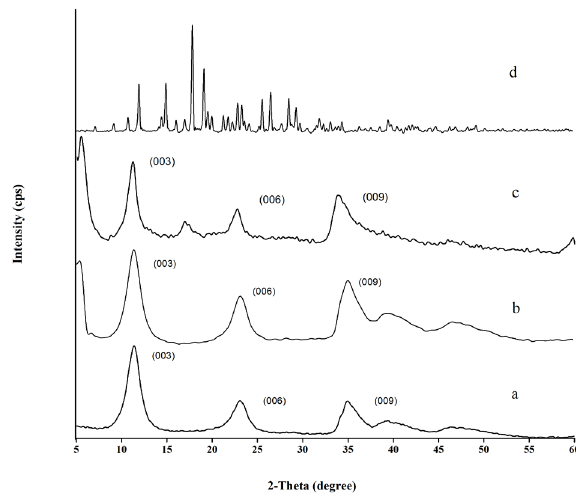
(a); Ni-Al-benzoate (b); Ni-Al- 3